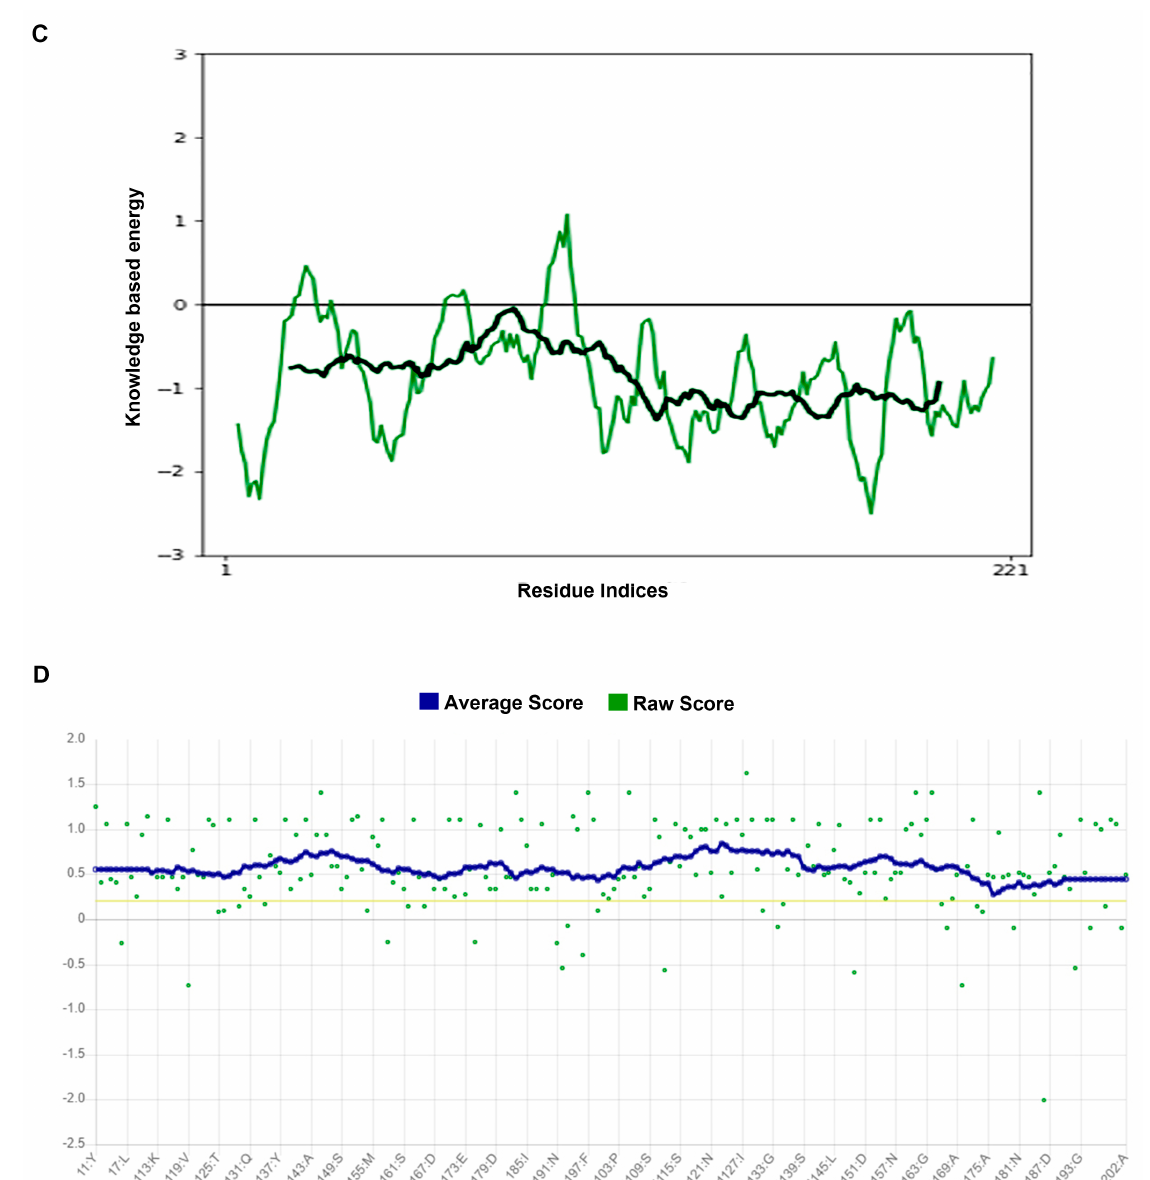
Figure 2. ( A ) Ramachandran plot of the predicted structure calculated by PROCHECK. Red represents the most favored regions and yellow represents the allowed regions; the model can be regarded as high quality when about 90% of the rotations are in red. A, B, L: most favorite regions. a, b, l, p: additional allowed regions; ~a, ~b, ~l, ~p: generously allowed regions; From A to a to ~a, the rationality of dihedral angle decreases in turn ( B ) Z-score of the predicted structure compared with the Z-scores of the experimental structures from different sources (X-ray and NMR); in the database, it is considered as a more reasonable structure if its Z-score falls within the range of the experimental structures. ( C ) Energy of all residues calculated by PROSA. A positive value means that the position of the corresponding residue is abnormal. The green line represents the energy of all residues calculated by PROSA and the black line represents the average energy of residues, which is calculated by taking a 40-residue window. ( D ) 3D/1D score of the predicted structure calculated by VERIFY_3D and the blue line represents the average score, which is the standard to judge the quality of the structure; it is considered as a high-quality model when more than 80% of the residues have 3D/1D scores higher than